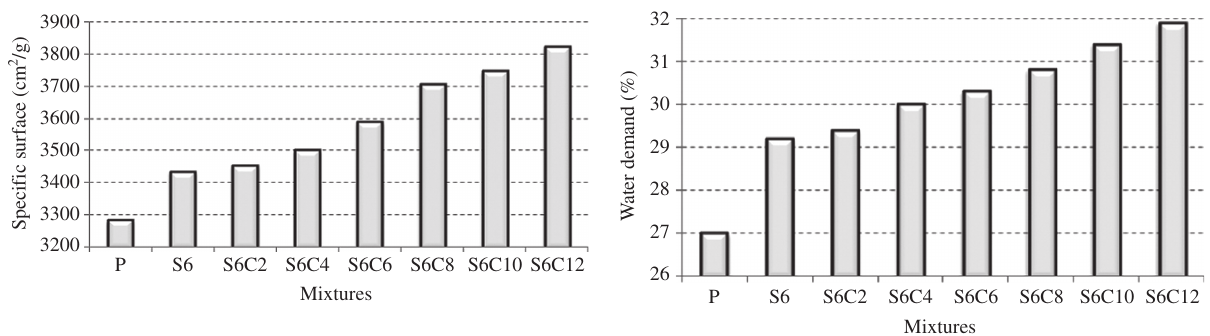
Figure 2 Setting times of mixtures.